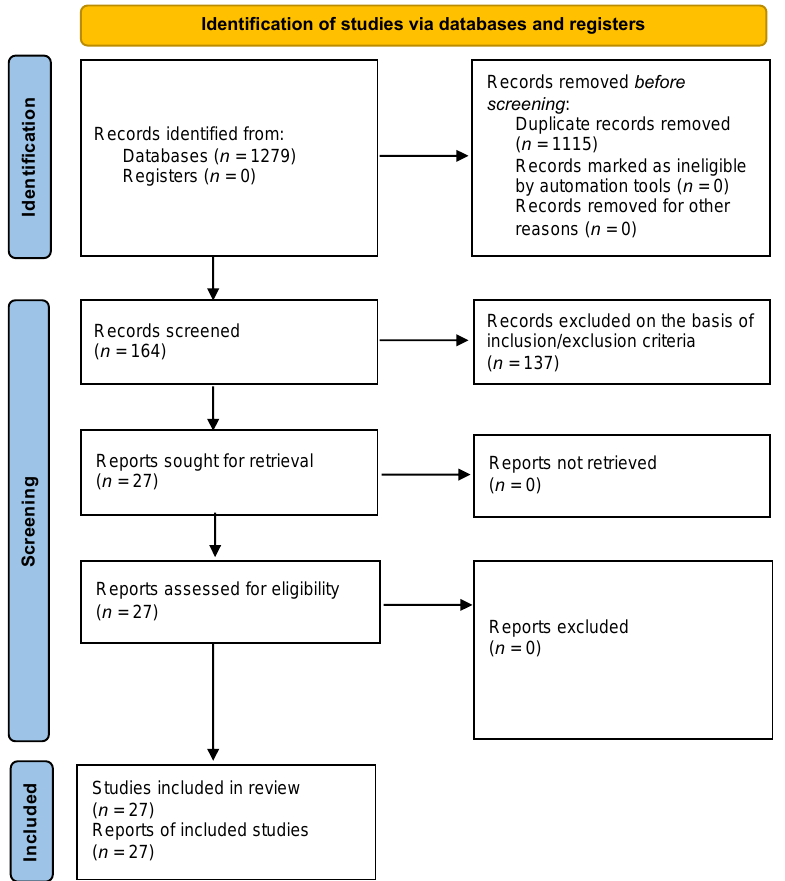
Figure 2. PRISMA flow diagram outlining the process used to identify and screen the articles obtained from electronic database and the subsequent selection of those included in the review [46].